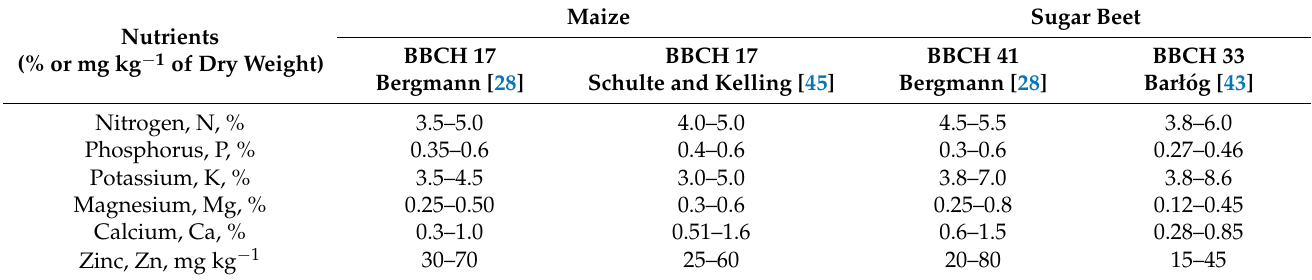
Table 1. Sufficient ranges of key nutrient contents in crop plants at the first cardinal stage (CK1).